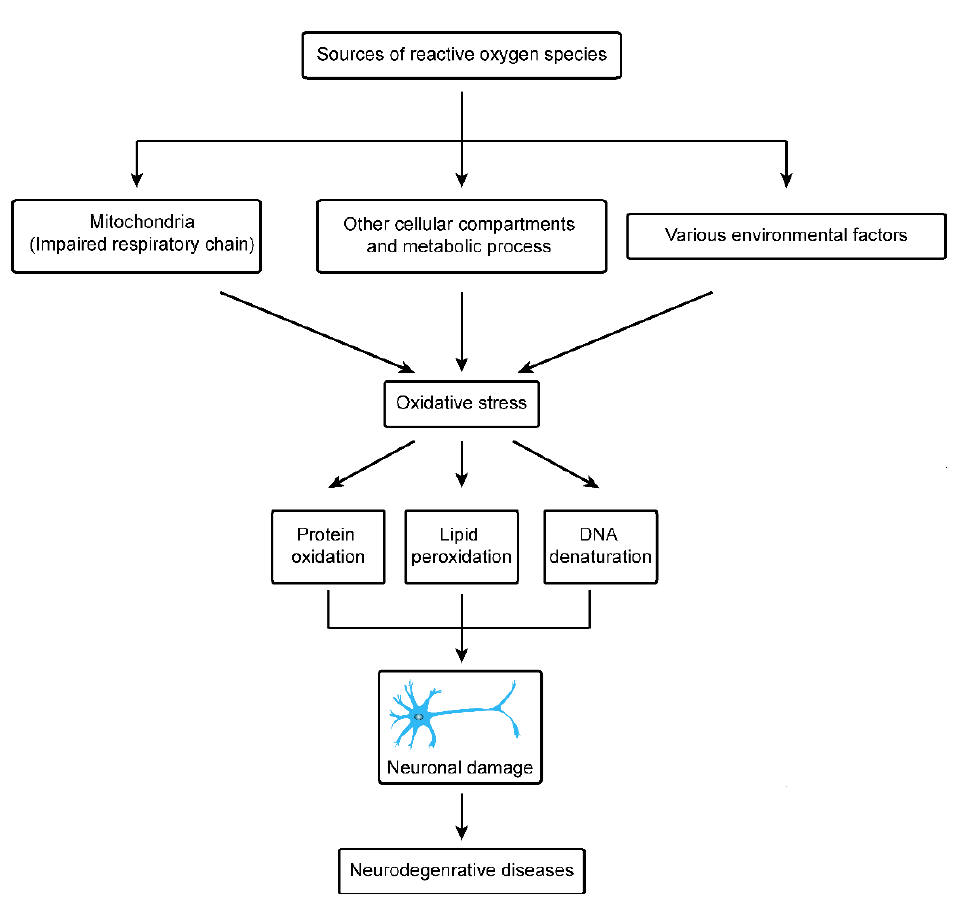
Figure 2. The causes of oxidative stress in neurodegenerative diseases.